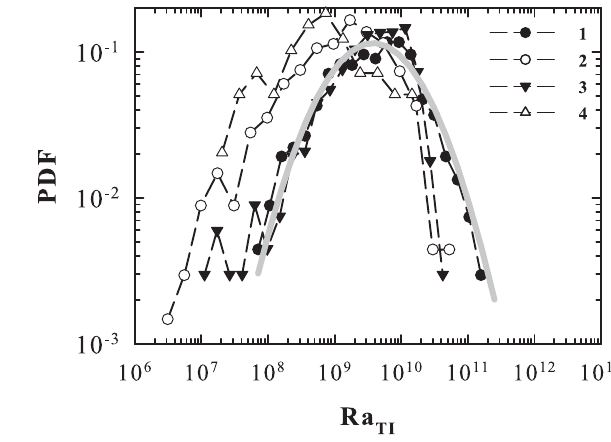
Fig. 4. Probability density functions (PDFs) of the thermal Rayleigh number, Ra TI , of the four diffusive interfaces. Data of the first, sec- ond, third and fourth interfaces are plotted using the dashed lines with solid circles, open circles, solid down triangles and open tri- angles, respectively. The log-normal fitting of the PDF of the first interface is shown as a gray